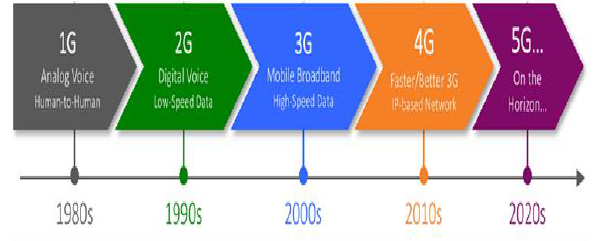
figure. Bellow a brief description of every generation: